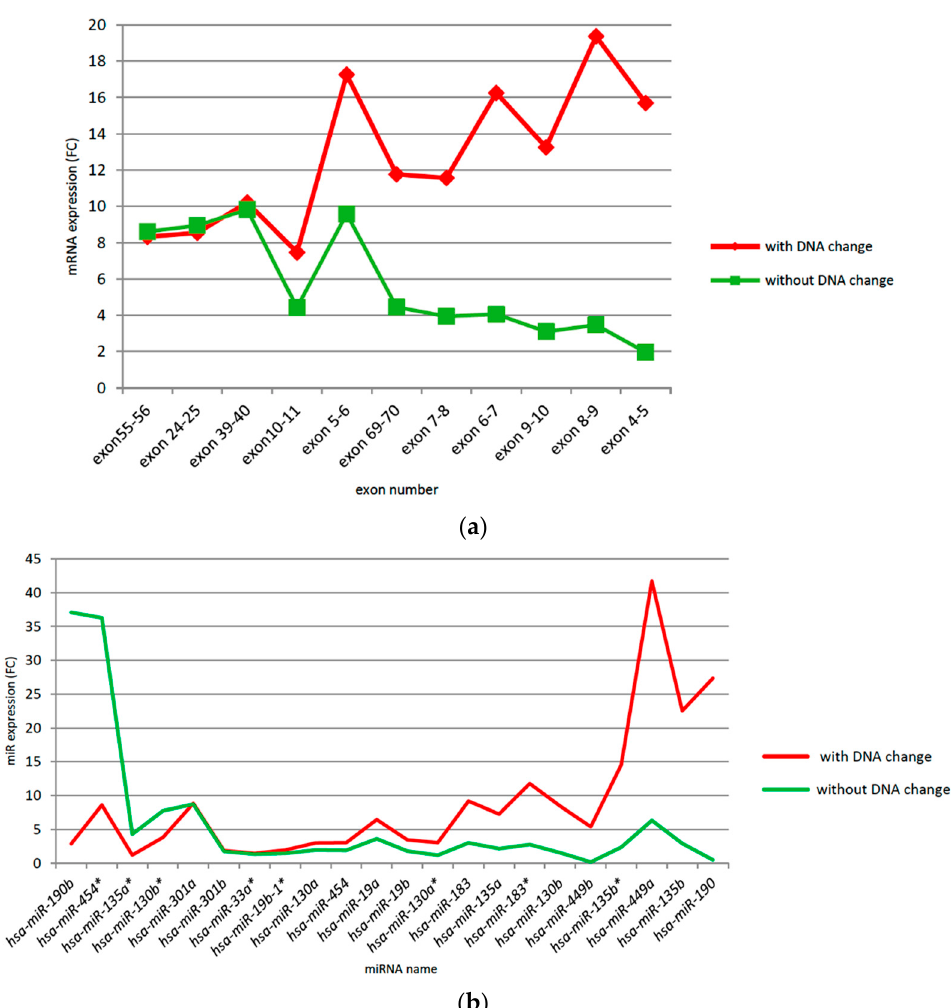
Figure 5. ( a ) CSMD1 expression in ESCC with and without somatic copy number alterations, allelic imbalance, and LOH. ( b ) Expression of CSMD1 target miRNAs in ESCC with and without somatic copy number alterations, allelic imbalance, and LOH.